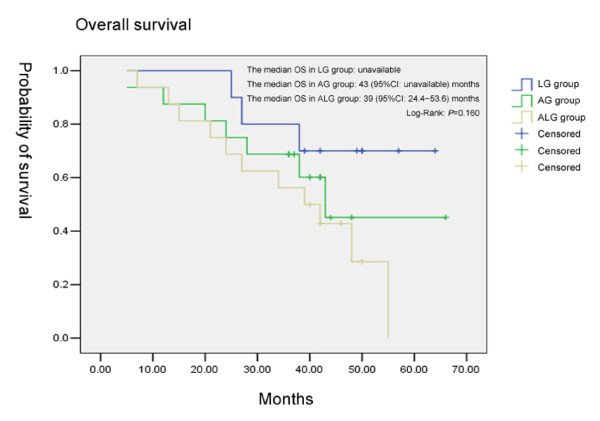
Comparison of the overall survival among the three groups.